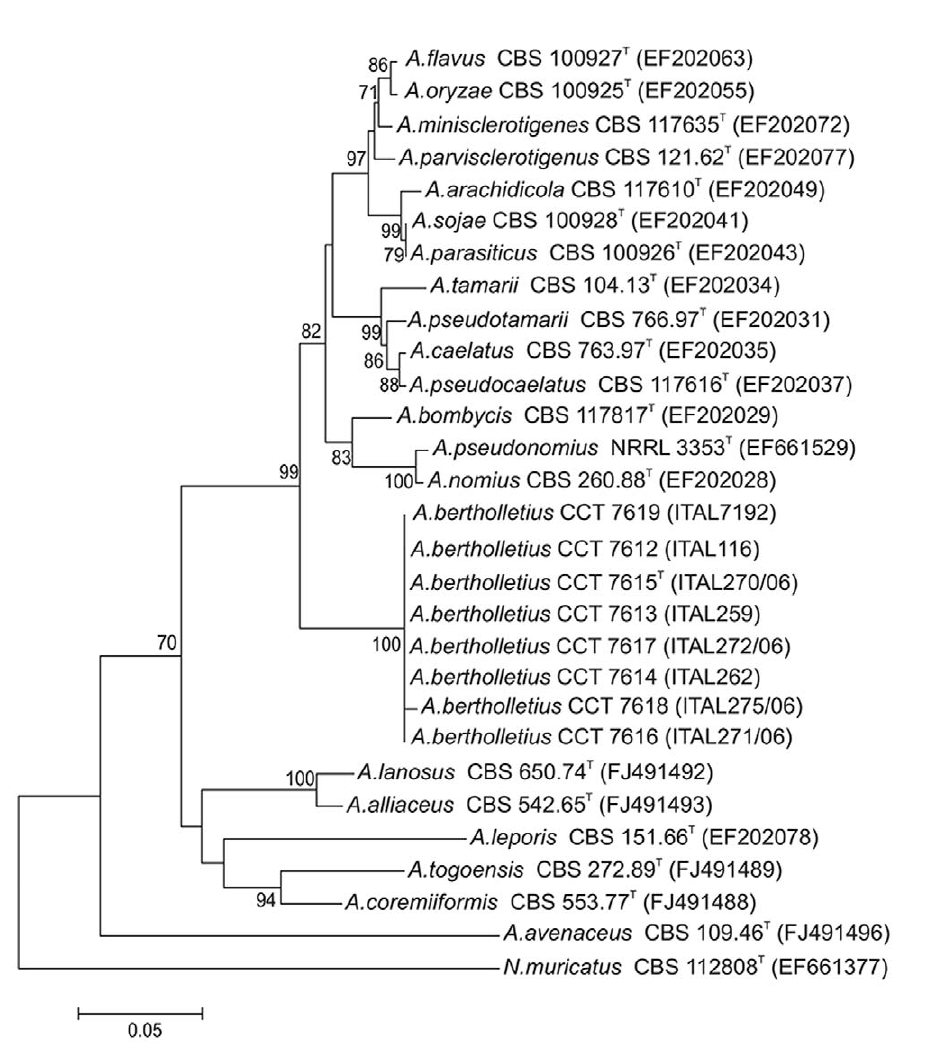
Figure 2. Neighbour joining tree reconstructed from the calmodulin partial gene sequences aligned with corresponding sequences of Aspergillus section Flavi type species deposited in public databases. Numbers at branch nodes refer to bootstrap values (1000 replicates), only values of . 70% are shown. The calmodulin nucleotide sequences from the type strain of A. bertholletius CCT 7615 (=ITAL 270/06) has been deposited in the GenBank databases under accession no. JX